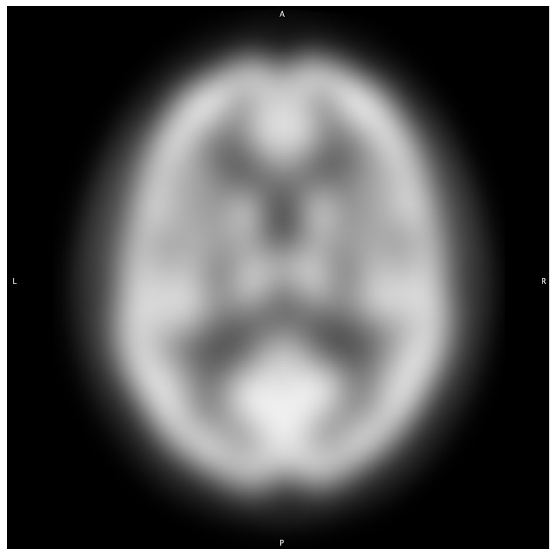
Figure 2. Axial cross section of the population template generated from 2, 068 clinical scans acquired at standard SPECT resolution and processed as described for display in the MNI single subject